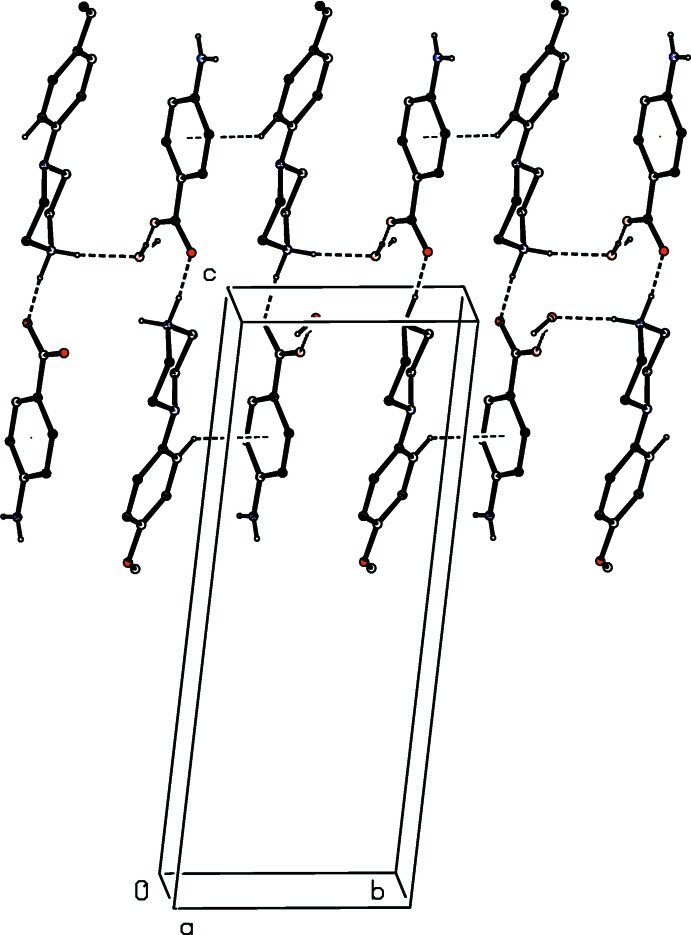
Part of the crystal structure of compound (IV) showing the formation of a hydrogen-bonded chain parallel to [010] and built from N—H⋯O, O—H⋯O and C—H⋯π(arene) hydrogen bonds; these are drawn as dashed lines and, for the sake of clarity, the H atoms bonded to the C atoms not involved in the motifs shown have been omitted.